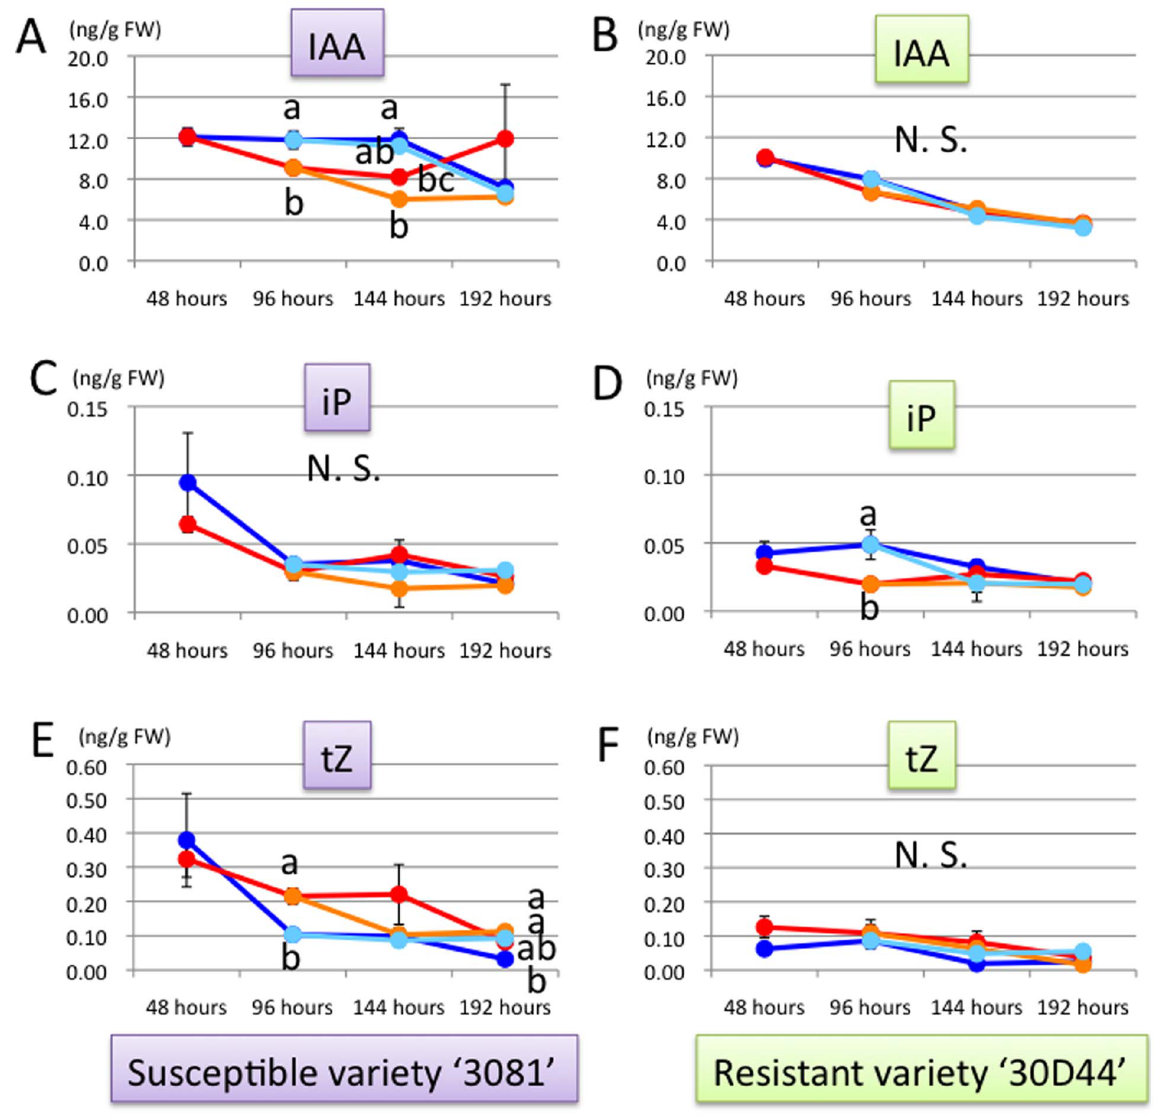
Figure 1. Changes in IAA, iP and tZ concentrations in the third leaf of maize. (A) IAA concentration (ng/FW) in the variety ‘3081’. (B) IAA concentration (ng/FW) in the variety ‘30D44’. (C) iP concentration (ng/FW) in the variety ‘3081’. (D) iP concentration (ng/FW) in the variety ‘30D44’. (E) tZ concentration (ng/FW) in the variety ‘3081’. (F) tZ concentration (ng/FW) in the variety ‘30D44’. Line colors indicate leafhopper treatment for eight days (red lines), control (blue lines), early leafhopper treatment for four days (orange lines), and late leafhopper treatment for four days (light blue lines). Different letters indicate significant differences between control and treatments at each time point (ANOVA; followed by Tukey’s HSD test at 144 and 192